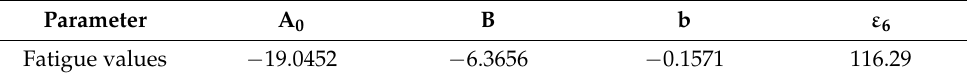
Table 1. Fatigue parameters of AC 16